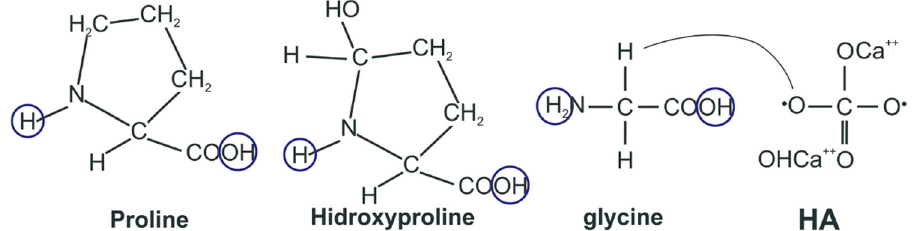
Figure 7: Bonding of hydrogen atoms in